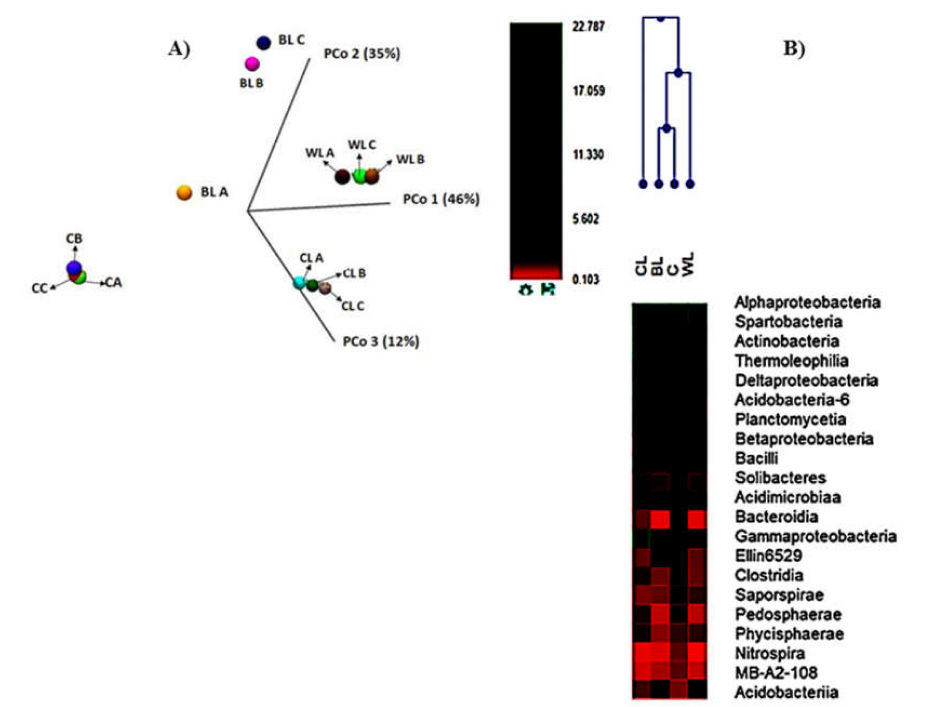
Figure 5. Principal coordinate analysis (PCoA) Euclidian beta diversity of the soil metagenomes ( A ), heat map and dendrogram ( B ) of the most abundant bacterial classes in the microbial community of soil